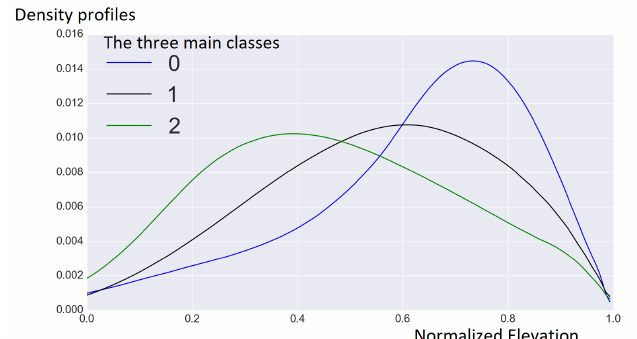
Figure 11. Three classes of vertical distributions in Laurentides Forest obtained by a spectral